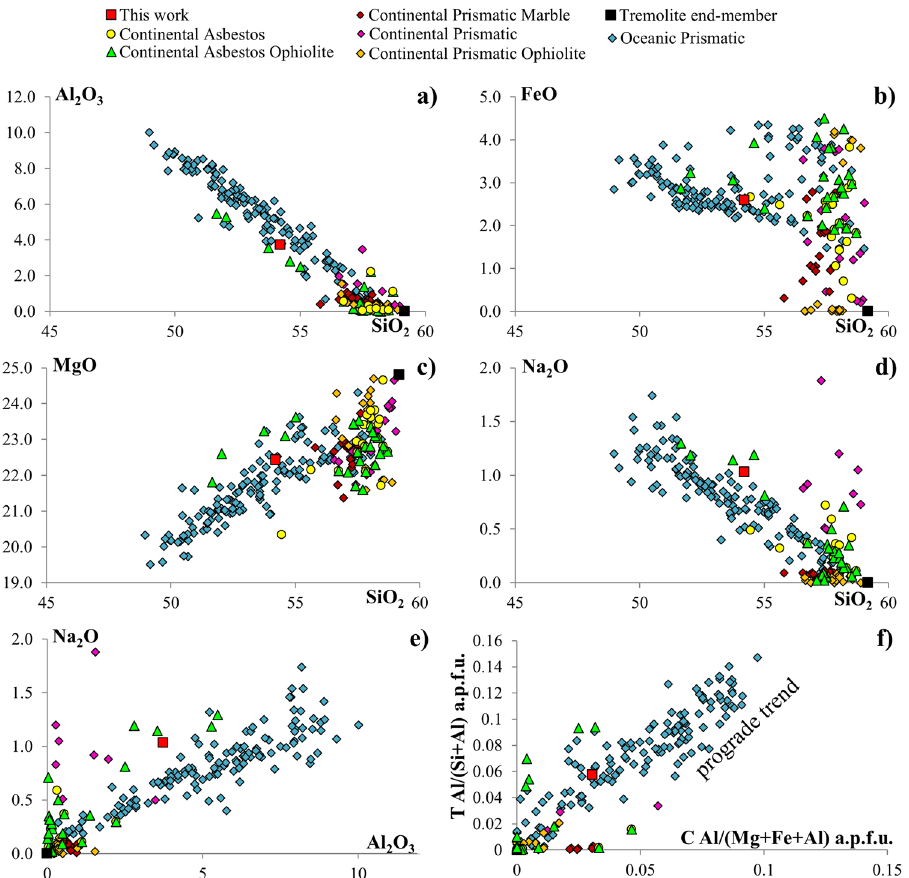
Figure 4. Comparison between the composition of the major elements of SMA1971-214 tremolite asbestos and that of tremolite amphiboles from oceanic and continental tectonic environments. ( a ) Al 2 O 2 (wt%) versus SiO 2 (wt%). ( b ) FeO (wt%) versus SiO 2 (wt%). ( c ) MgO (wt%) versus SiO 2 (wt%). ( d ) Na 2 O (wt%) versus SiO 2 (wt%). ( e ) Na 2 O (wt%) versus Al 2 O 3 (wt%). ( f ) Al/(Al + Si) in T site (a.p.f.u.) versus Al/(Al + Mg + Fe) in C site (a.p.f.u.). ± 1 σ compositional variability of tremolite SMA1971-214 is within the symbol area. See Supplementary Information for